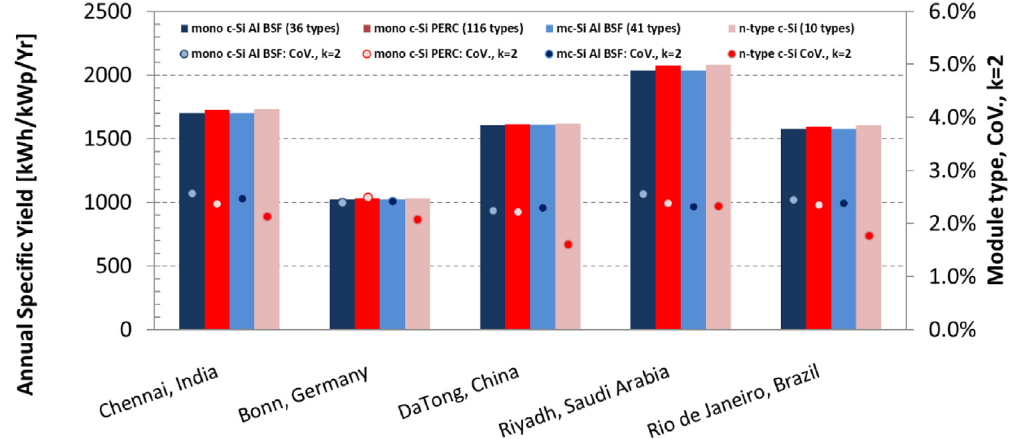
Fig. 6. Variation of speci fi c energy yield over 5 sites and coef fi cient of variation for 4 module types. Bars represent the annual speci fi c yield and dots the coef fi cient of variation of speci fi c yield from type to type ( k